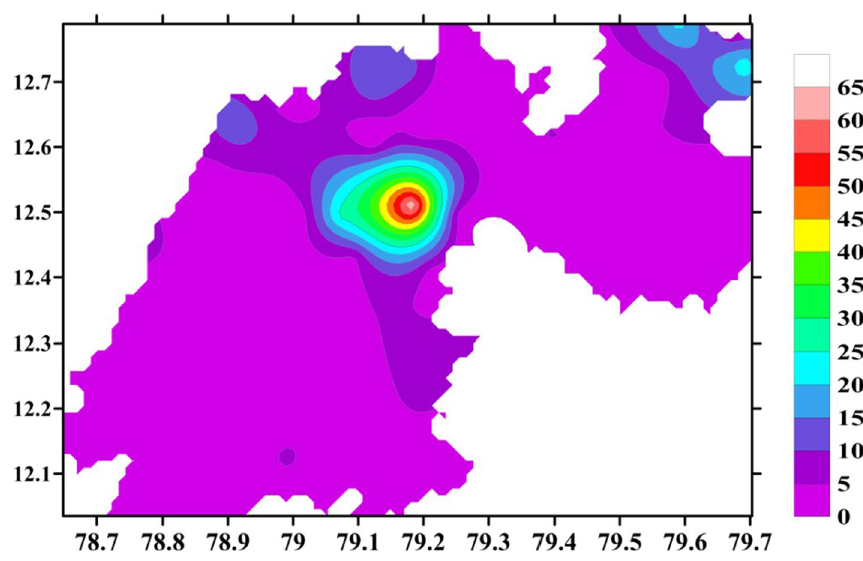
Fig. 21 Spatial variation of annual whole body dose in adult